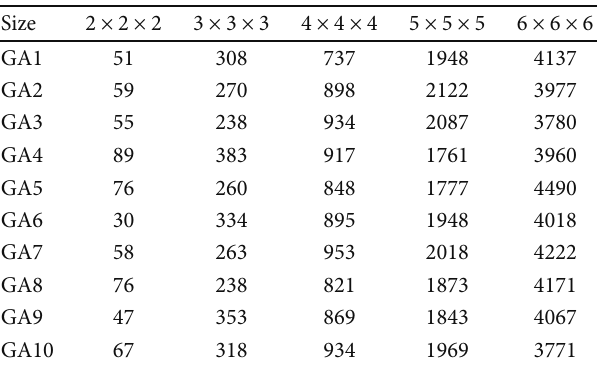
Table 8: Solution lengths with 200 macros.